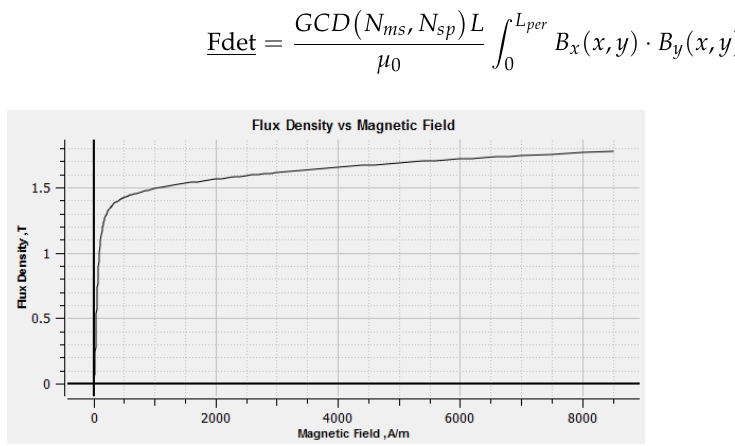
Figure 13. BH curve of 35H210 silicon steel sheet.